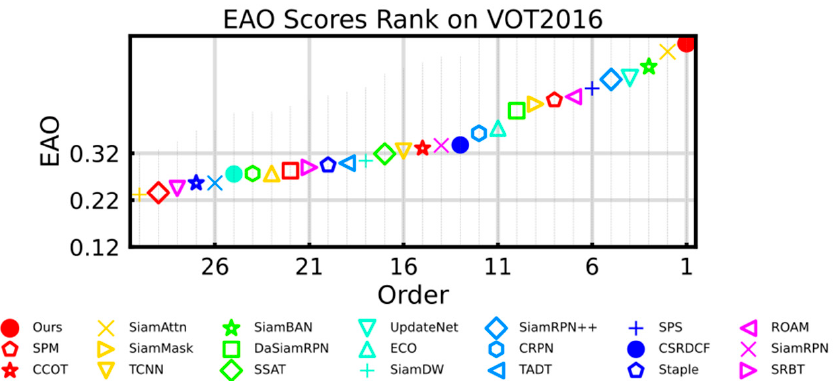
Table 1. Performance comparisons on VOT2016 benchmark. Figure 5. Expected Average Overlap (EAO) ranking of the evaluated tracker on VOT2016 benchmark.